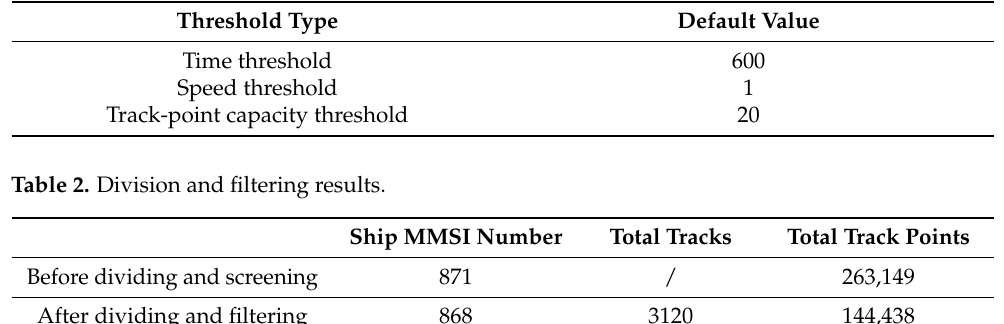
Table 1. Division and filtering threshold settings.